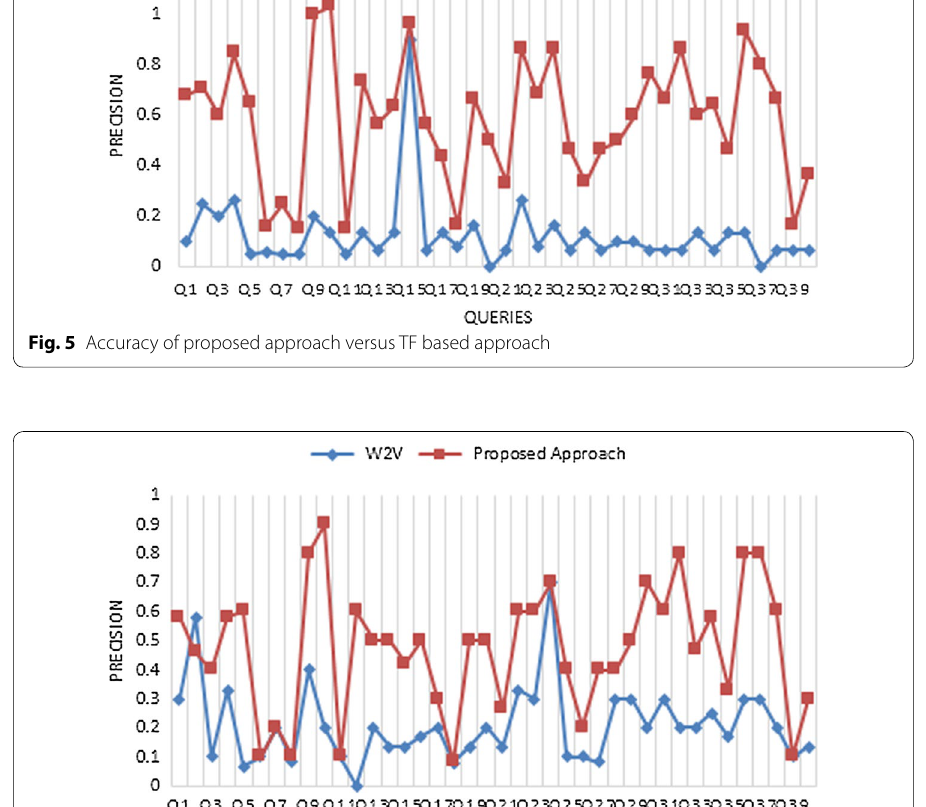
Fig. 6 Accuracy of proposed approach versus w2v‑based